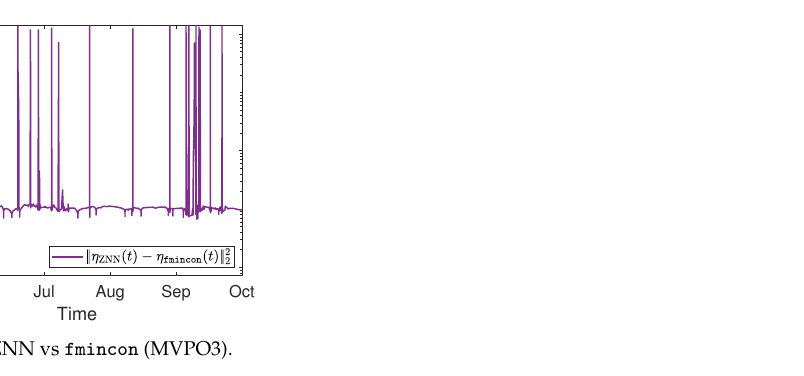
Figure 3. Portfolios variance %, expected return, and the error between ZNN and MATLAB’s solvers in case 2.